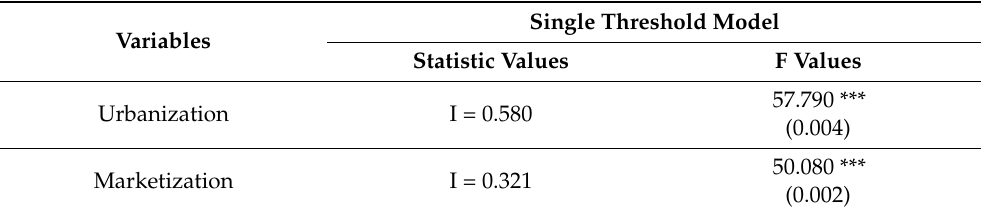
Table 5. Threshold effect test of urbanization and marketization on carbon